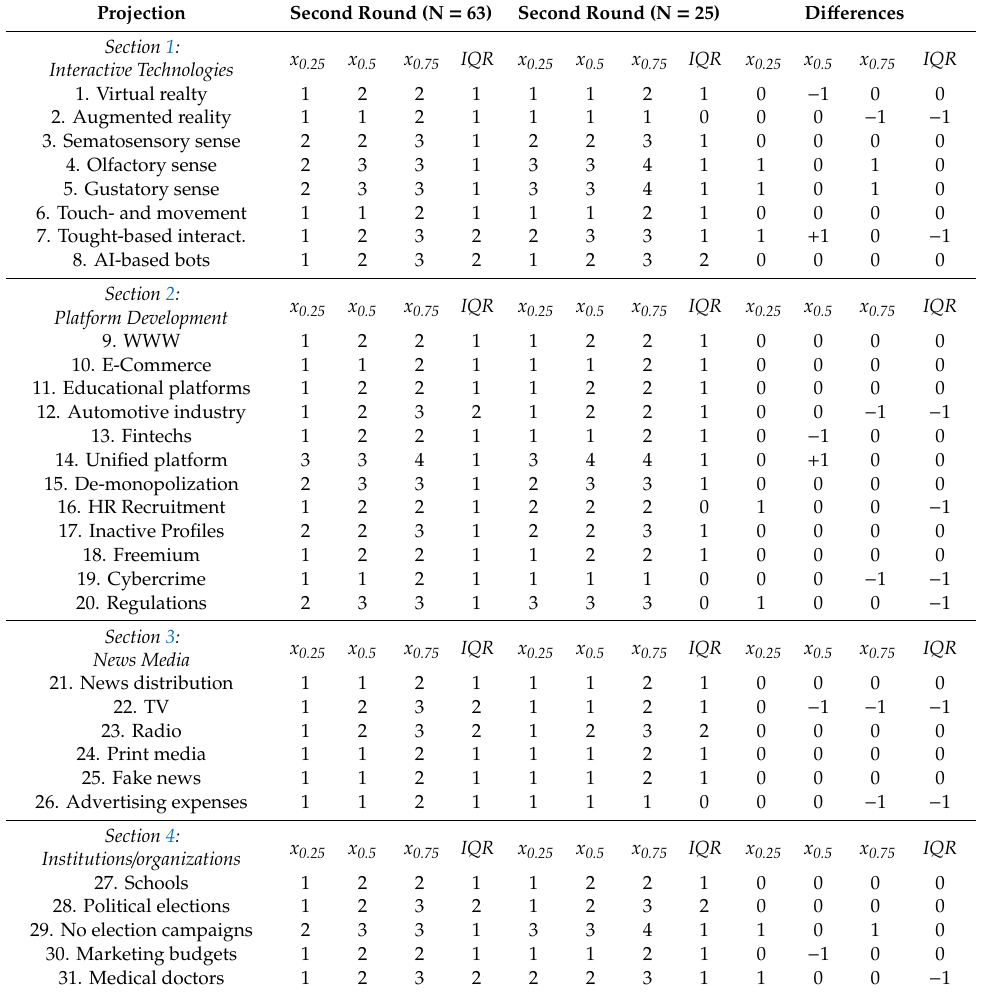
Table 3. Results of both